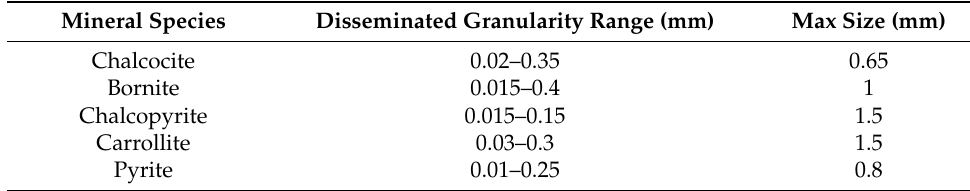
Table 4. The disseminated granularity of main metallic minerals.